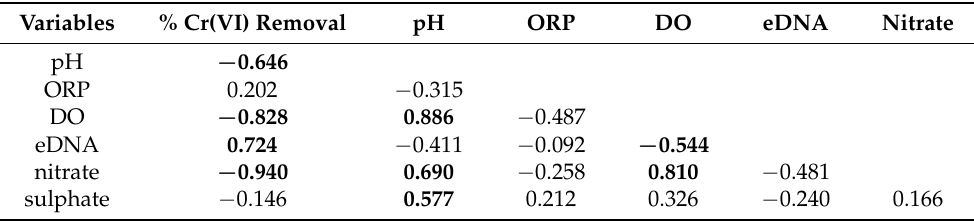
Table 4. Correlation between the monitored parameters (Pearson’s coefficient, n). Strongest correla- tions (n > |0.5|) are in bold.